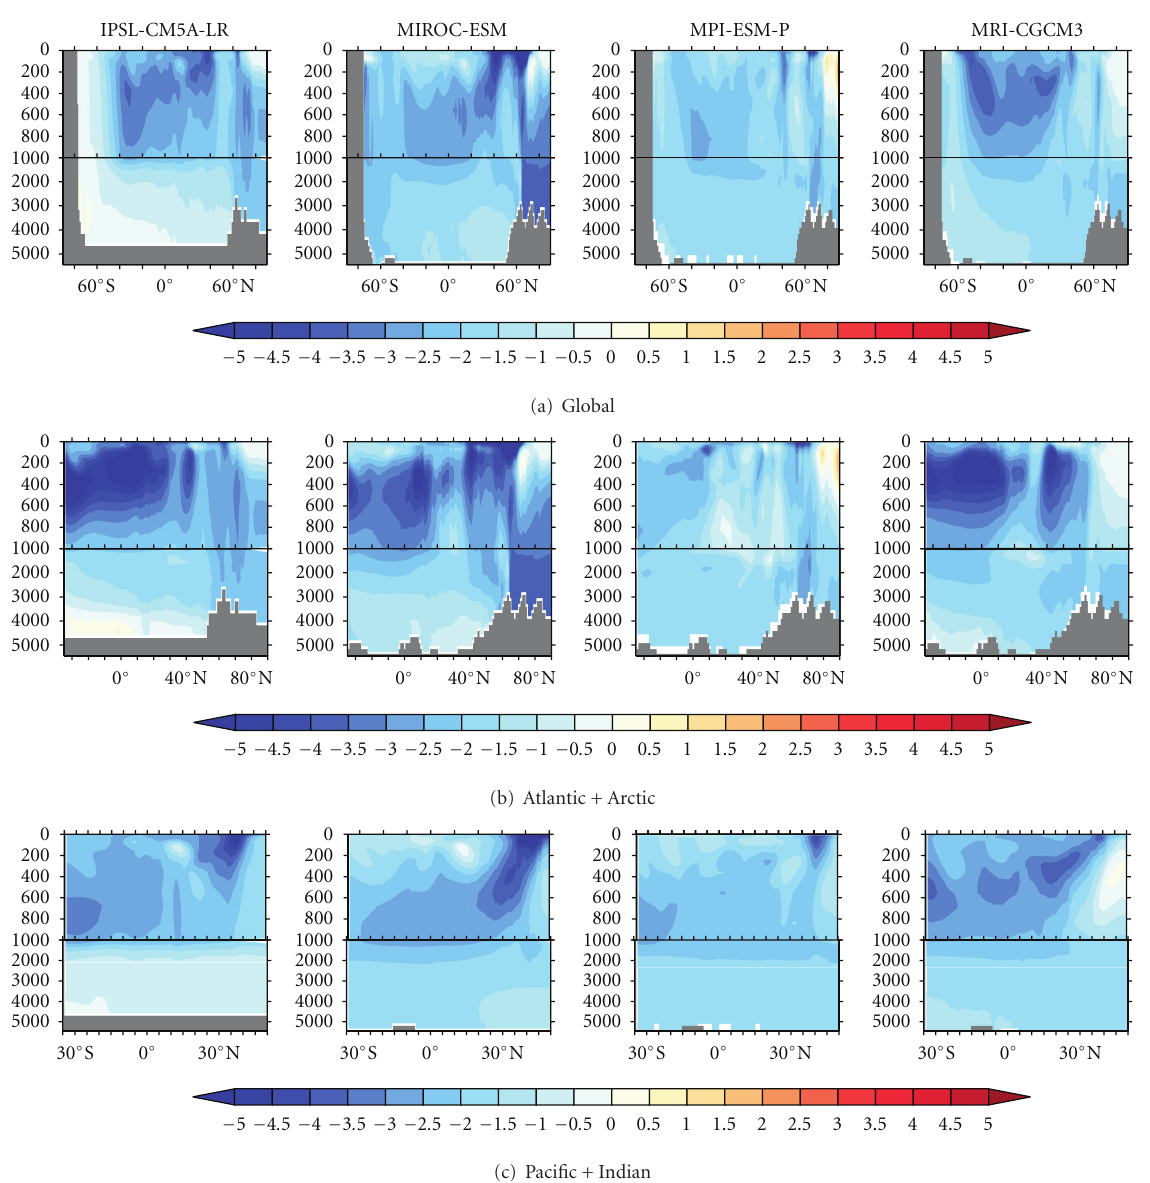
Figure 2: Latitudinal cross-sections of global mean (a) and ocean basins (b through c). The abscissa is latitude in degrees and the ordinate is water depth in meters. Notice that depth is unevenly distributed. The temperature anomaly is in ◦ C. Cooling occurs mostly in the upper ocean. Cooling in the Atlantic and Arctic Oceans is deeper than in the Pacific and Indian